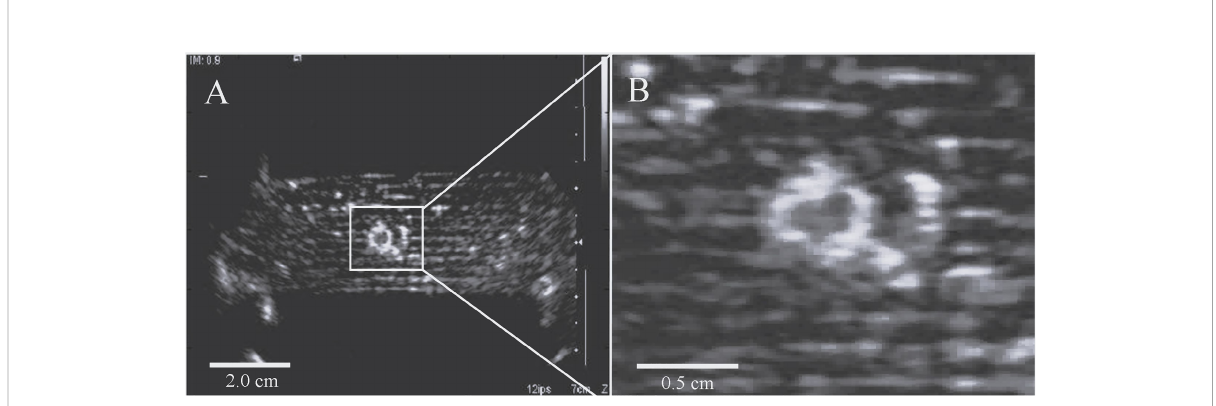
FIGURE 8 (A) Residual signal hyperintensity observed with B-mode ultrasonography after circular-pattern focused ultrasound sonication in perfused tissue mimicking phantom. (B) Magni fi ed region of